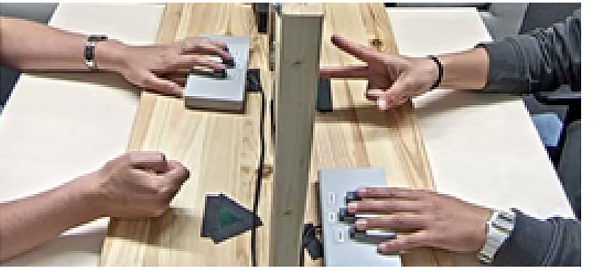
Figure 3. A picture of the experimental set-up. The participants sat on the left and the right side of the table. The experimenter operating the panel was located in the middle. Participants placed their left hand on the button press apparatus and performed the actions with their right hands without lifting their arms (note: Informed consent was obtained to use the